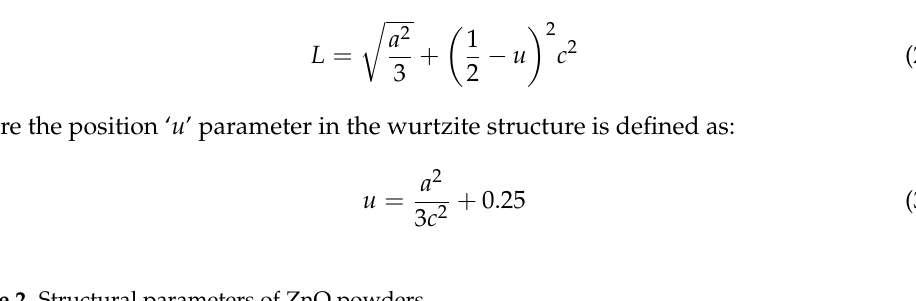
Table 2. Structural parameters of ZnO powders.